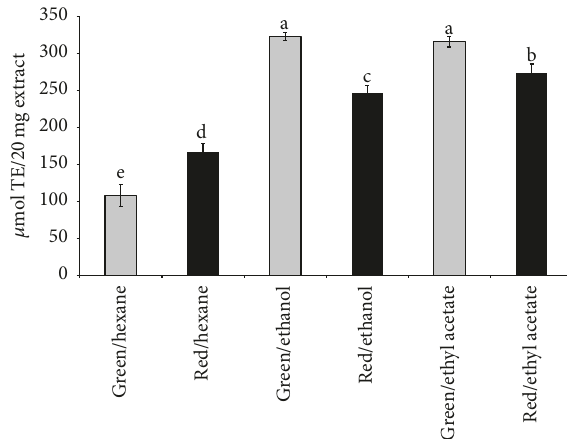
Figure 2: Antioxidant activity of GCPS and RCPS oils extracted with different solvents. a – d Different letters above bars indicate that samples are significantly different ( 𝑝 < 0.05